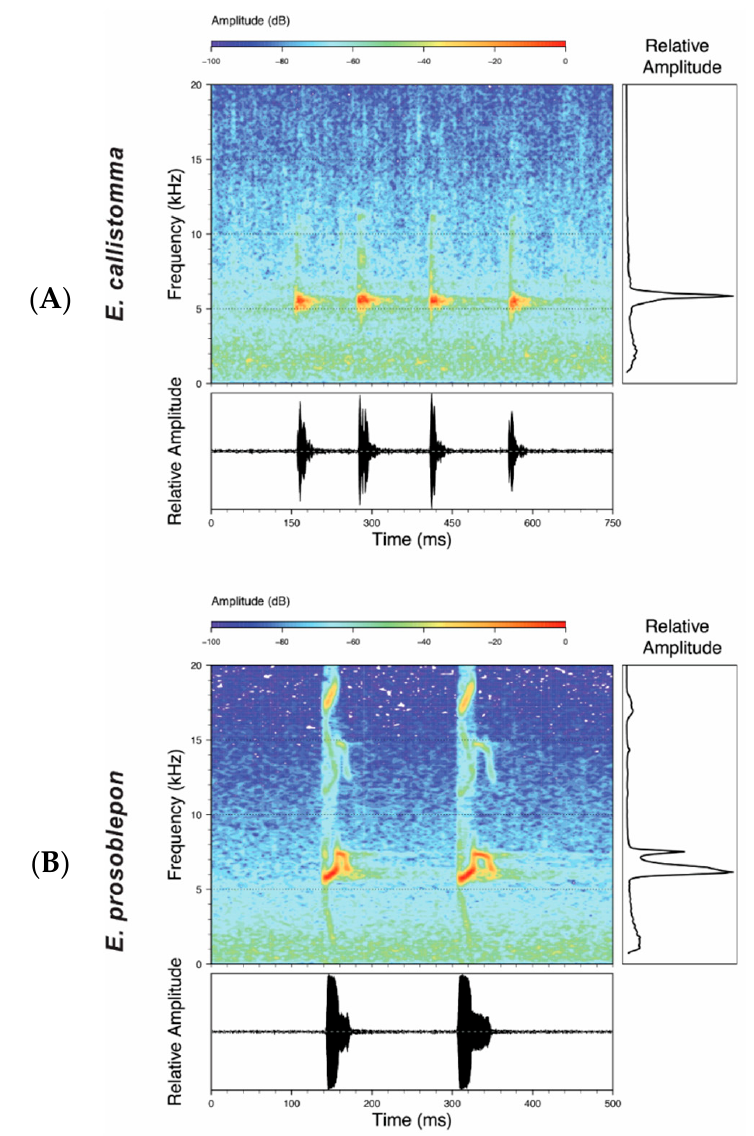
Figure 91. Calls of Espadarana . ( A ) Call of Espadarana callistomma from Reserva Otokiki, 706 m, Esmeraldas province, Ecuador, LBE-C-022. ( B ) Call of E . prosoblepon from Cordillera de Chontilla, 908 m, Pichincha province, Ecuador, MZUTI 601. Tadpole: Not